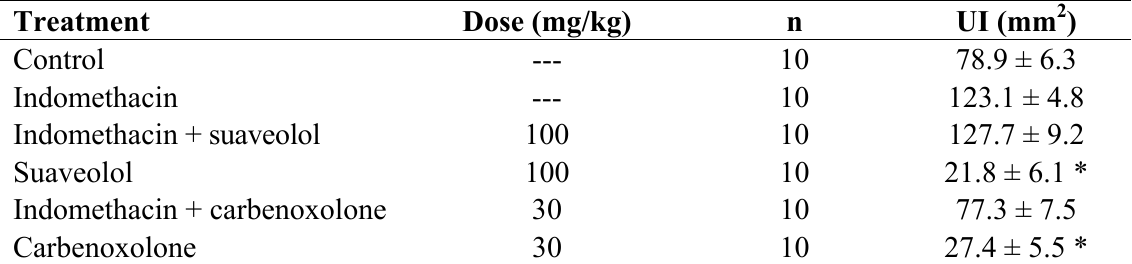
Table 4. Effect of suaveolol and carbenoxolone on gastric lesions induced by ethanol in rats pretreated with indomethacin (10